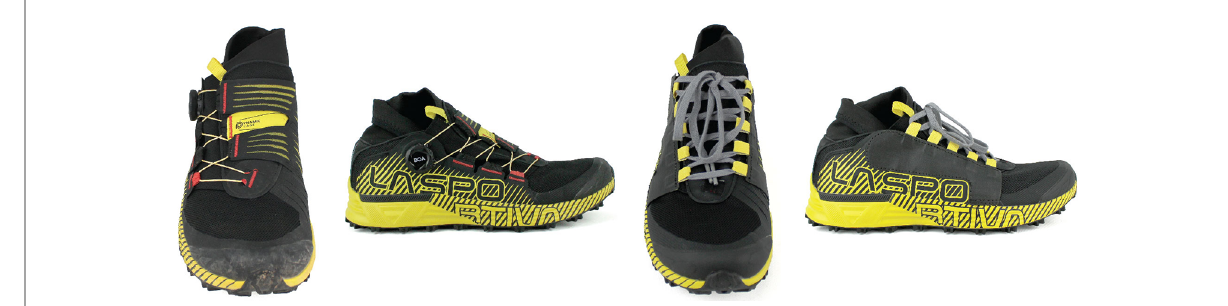
FIGURE 1 The La sportiva cyklon with the wrap upper (left) and the retro- fi tted lace version of the shoe (right).